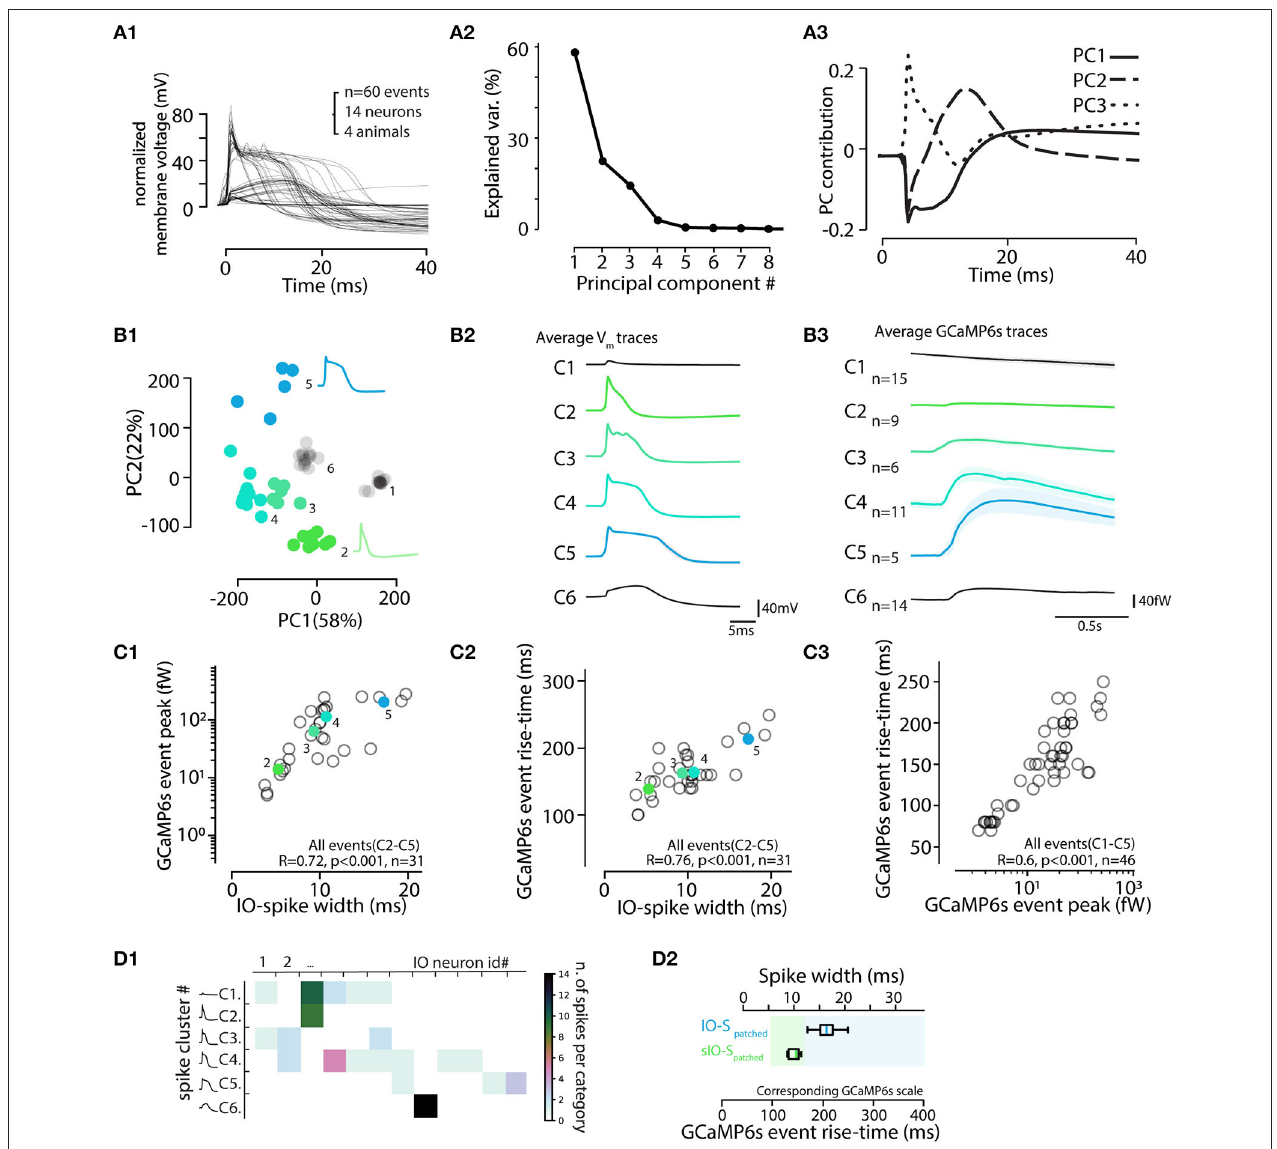
FIGURE 8 | Electrophysiological features of IO action potentials are reflected in the GCaMP6s event waveform. (A) Principal component analysis of IO action potential waveforms. (A1) 60 voltage spike events detected and aligned on initiation point. (A2) Relative contributions of the principal components to the waveform variability. The 3 first PCAs explain 95%. (A3) Time-varying contributions of the 3 first PCAs, corresponding to the “calcium shoulder” (solid line), after-hyperpolarizarion (dashed line), and the sodium spike (dotted line). (B) Clustering IO calcium events (eCAs) based on the PCA analysis in (A) . (B1) k -means clustering (indicated by colored markers) of the IO action potentials shown in (A1) . (B2) Averaged electrophysiological waveforms from the clusters identified in (B1) . (B3) The average calcium event waveforms linked to the electrophysiological clusters in (B1,B2) . Note that no noticeable calcium transients are seen linked with cluster 1 that corresponds to “spikelet” events (see Figure 7 ). Also, the calcium events belonging liked to cluster 6 events lacking a full sodium spike are very small in amplitude. Spikes from cluster 6 are excluded from rest of analysis, and only the 46 spikes [corresponding to clusters 1–5] recorded in 13 healthy IO neurons are depicted in following. (C) Calcium event peak amplitudes (C1) and rise times (C2) strongly correlate with the electrophysiological spike widths (n = 31 events, clusters 2–5). Note that the eCa amplitude-to-spike width relation saturates with longest spikes, while rise time to spike width relation is more robust. (C3) Relation between calcium event rise time and peak amplitude. Note slight non-linearity with largest events. The colored points and black circles represent average values for respective clusters and individual observations respectively. Events from clusters 1 and 6 are not shown in (C1,C2) as they correspond to spikelets and unhealthy neuron spikes. (C3) consists of data from clusters 1–5. (D) Spike cluster diversity in different recordings. (D1) Number of spike cluster observations for each cell. Note that the “incomplete spikes” (cluster 6) and “short IO spikes” (cluster 2) are only seen in single cells each while spikes from other clusters are seen in multiple cells. (D2) Box-plot including data from clusters 2–5 providing suggestive translation scale between observed calcium event rise time (bottom scale) and the corresponding electrophysiological spike width (top scale). Calcium events with rise times longer than 150 ms correspond to “normal” IO spikes (IO-S). The “short IO spikes” (sIO-s) do not present a clear calcium shoulder and may be caused by unusual physiological state of the IO neuron, possibly due to major damage to dendrites caused by slice preparation.